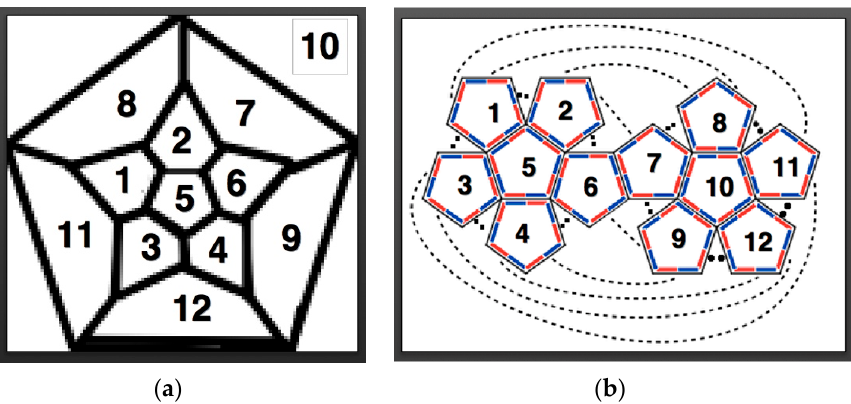
Figure 4. Two different representations of which pentagons in a planar representation of a dodecahedron bind together: ( a ) a Schlegel diagram; and, ( b ) the corresponding Dürer net of a dodecahedron have been numbered 1–12, such that each pentagon with the same number on the corresponding configurations are the same.